Question: Name the type of graph shown.
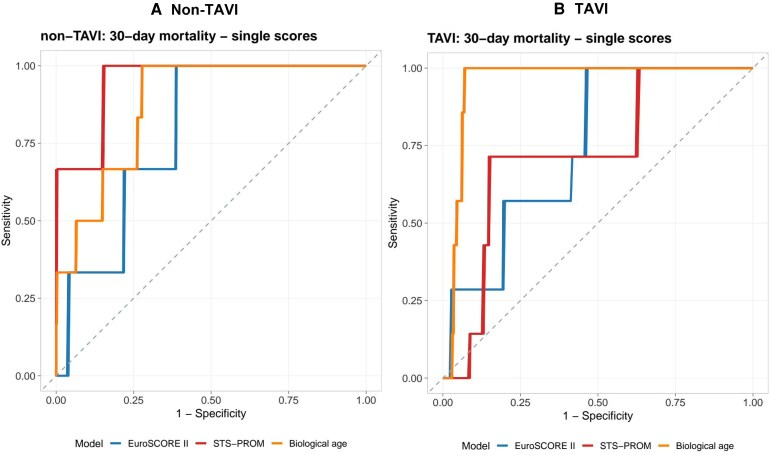
Answer: line